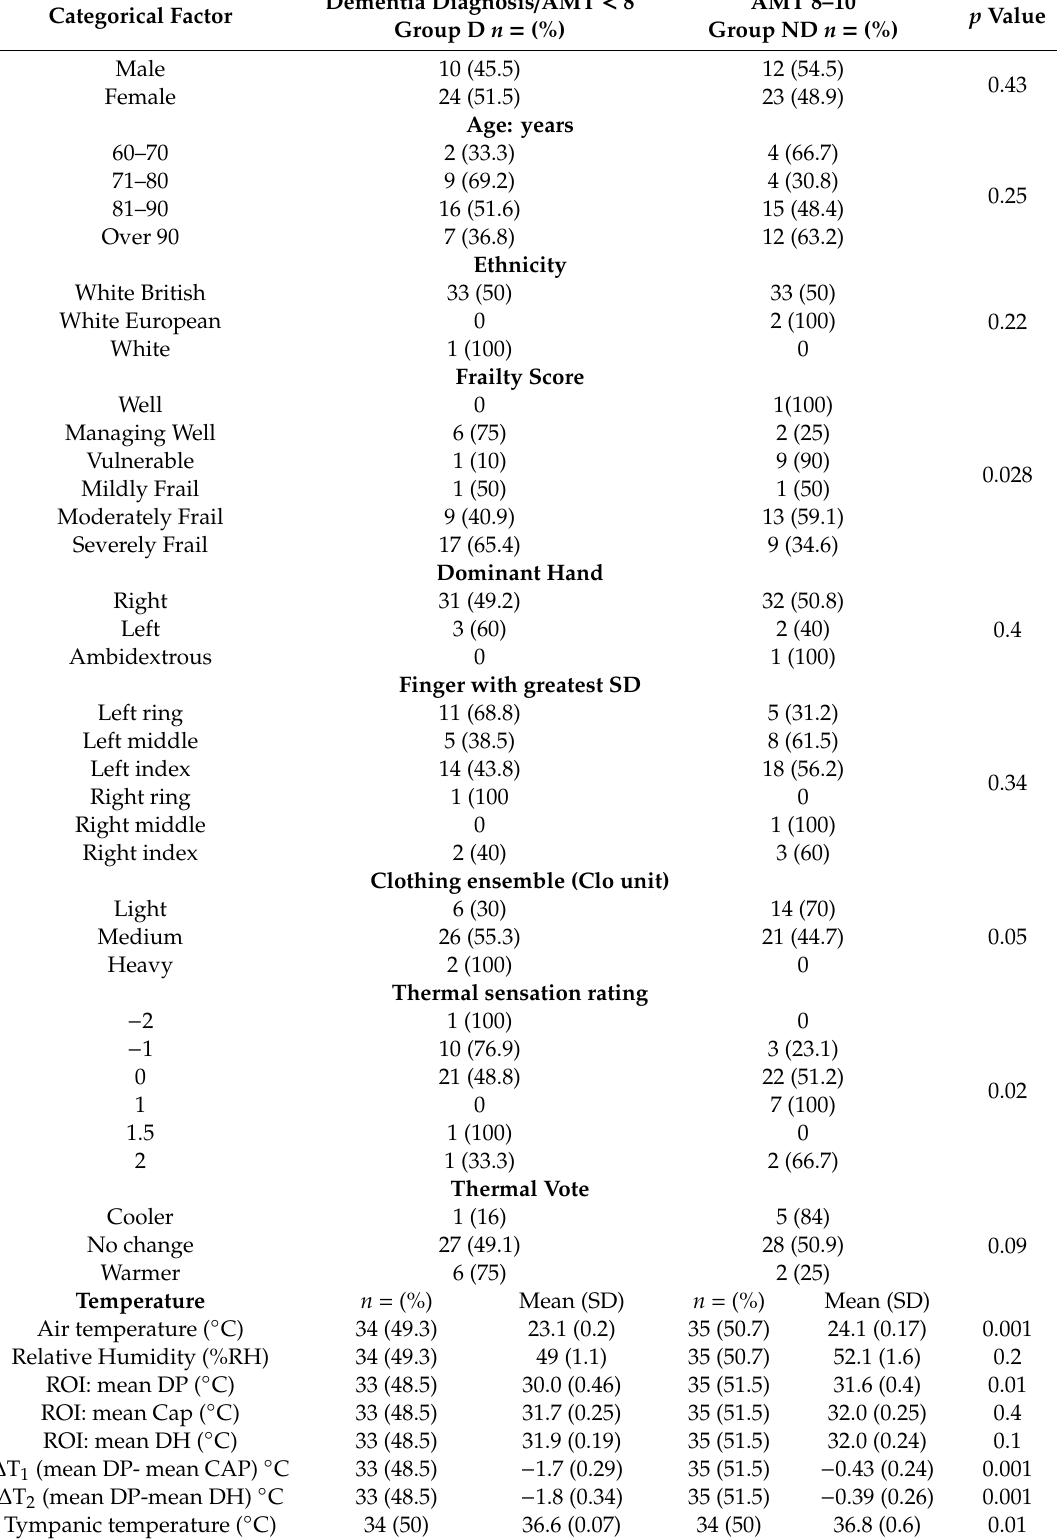
Table 1. Characteristic of care home residents, clothing ensemble, ambient conditions and core and skin temperature values ( ◦ C) with temperature di ff erence ( ∆ T). Table shows descriptive analysis that focused on associations between key